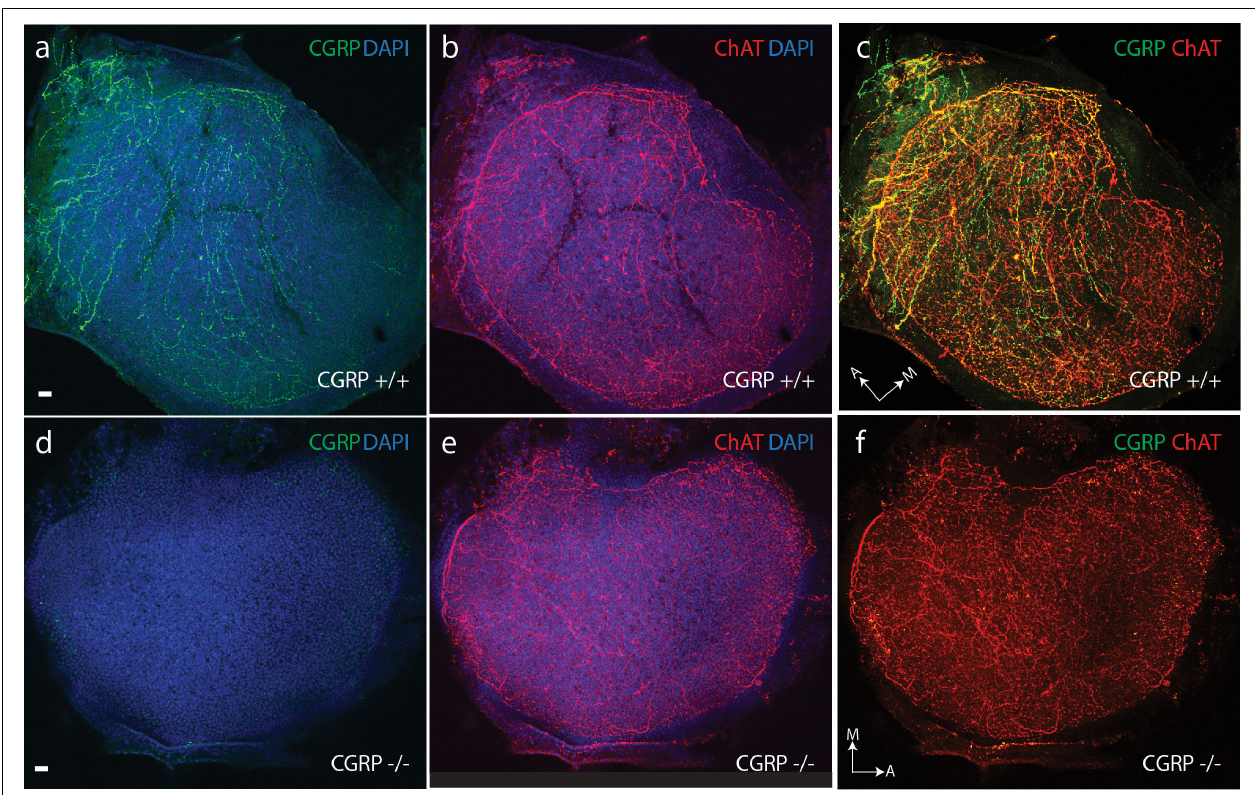
FIGURE 2 | CGRP is abundantly present in the neuroepithelium of CGRP (+/+) mouse otolithic organs (a) with a distribution overlapping choline acetyltransferase (ChAT) expression (b) as illustrated in the composite image (c) . (d) CGRP is absent in the neuroepithelium of CGRP (–/–) mouse otolithic organs, while choline acetyltransferase (ChAT) expression (e) is comparable to that seen in the wildtype controls (b) . (f) Composite image for CGRP (–/–) otolith showing only ChAT staining. Staining for CGRP (green) and choline acetyltransferase-ChAT (red) with overlap indicated in yellow and orange. Arrows with letter labels indicate the anatomical orientation of the medial (M) and anterior (A) axes of the utricular maculae. Scale bars = 10 µ